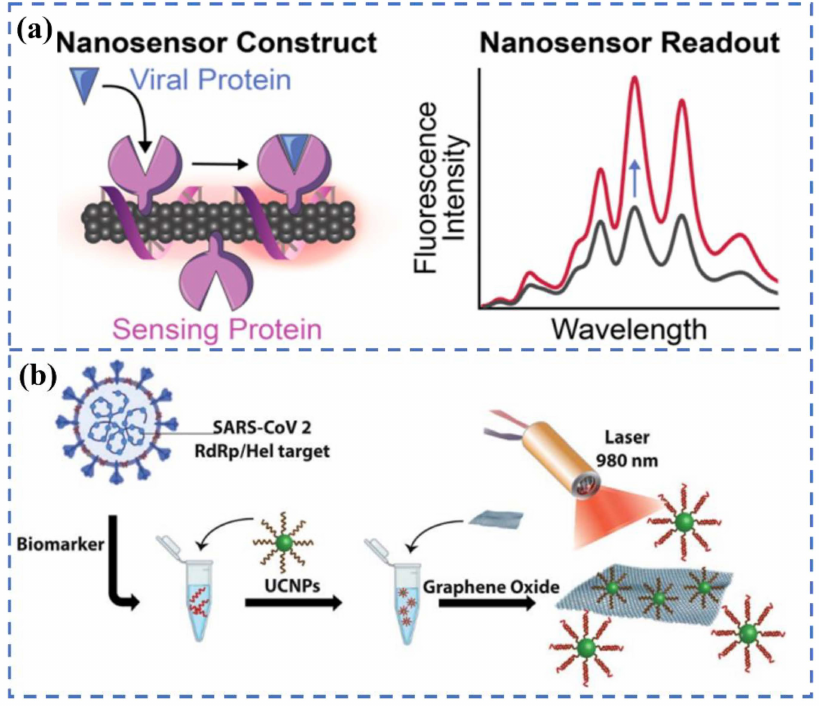
Figure 4. ( a ) Construction of the ACE2-SWCNT nanosensor formation to sense protein ACE2. Reprinted with permission from ref. [52]. Copyright 2021, American Chemical Society. ( b ) Detection of the RdRp/Hel gene of SARS-CoV-2 via an upconversion nanoparticles/graphene-based biosensor. Reprinted with permission from ref.